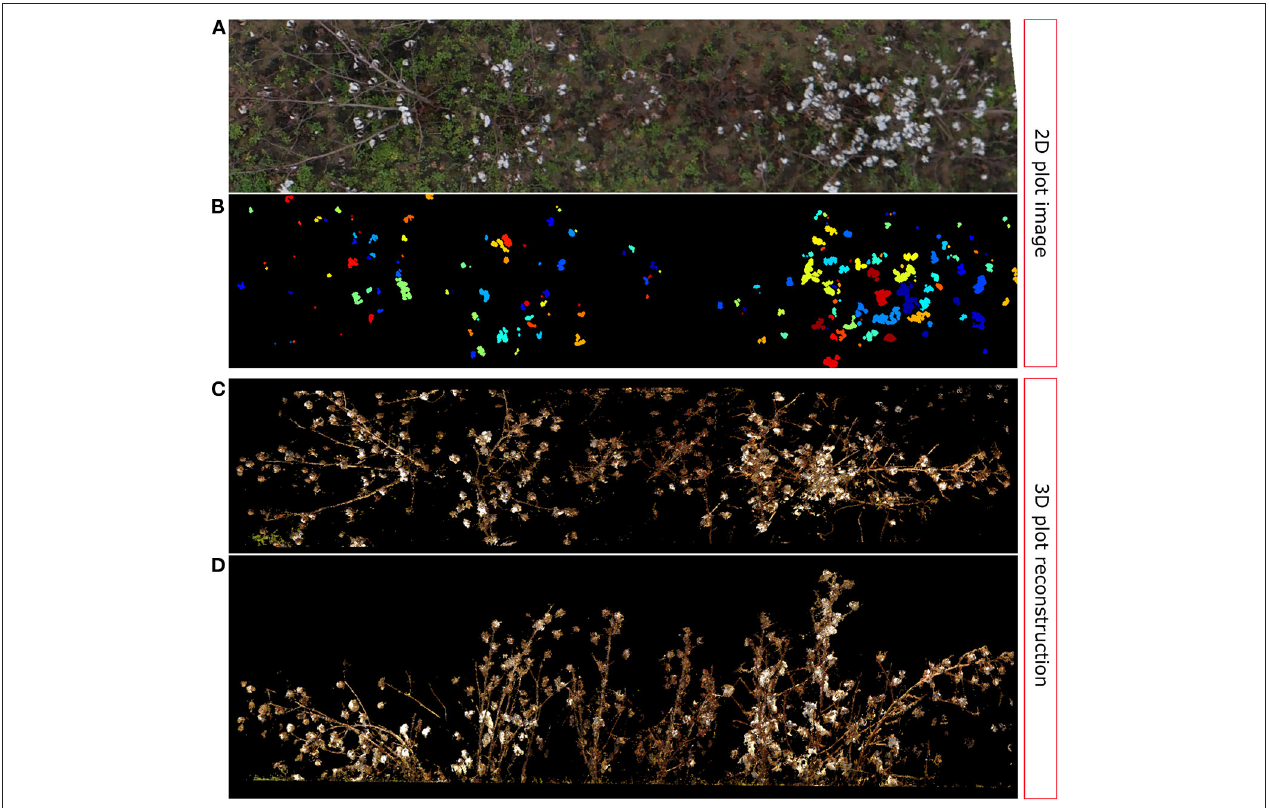
FIGURE 13 | Outlier analysis: 2D vs. 3D comparison. (A) Original image plot (Plot ID 41028), (B) Cotton boll clustering results; each cluster is identified by a unique color, (C) TLS reconstructed 3D point cloud: Top view, (D) TLS reconstructed 3D point cloud: Frontal